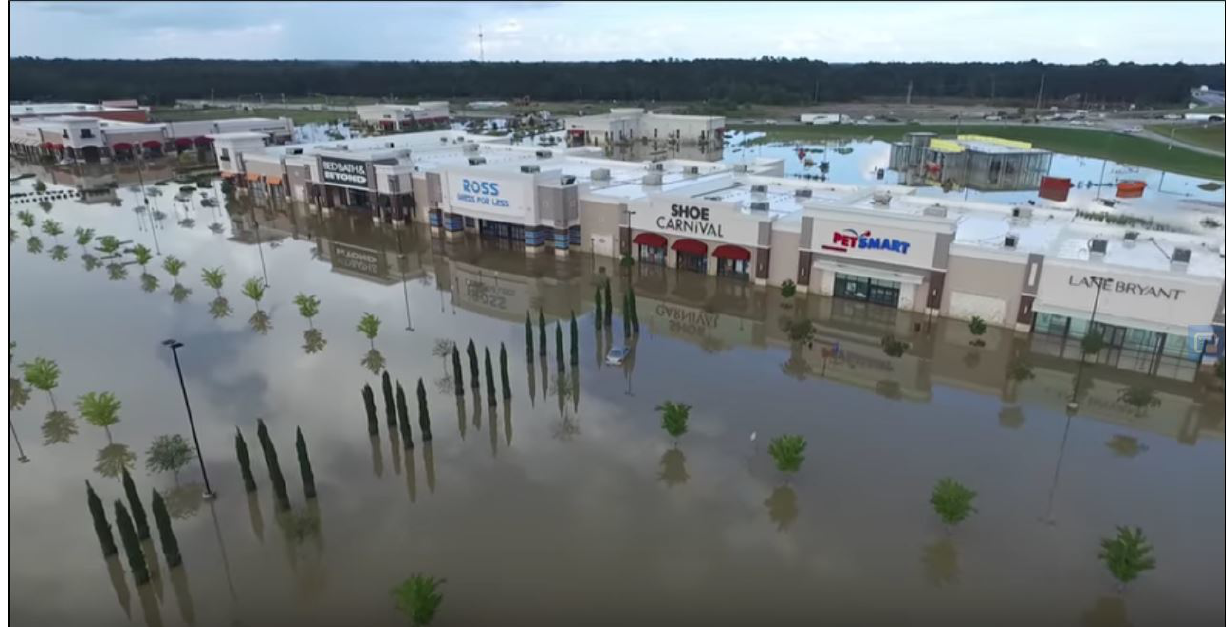
Figure 3: Juban Crossing Shopping Center captured by Dev/Null, “Louisiana Flood 2016—Denham Springs/ Juban—Drone Aerial Footage,” YouTube, Aug 15, 2016. Source: